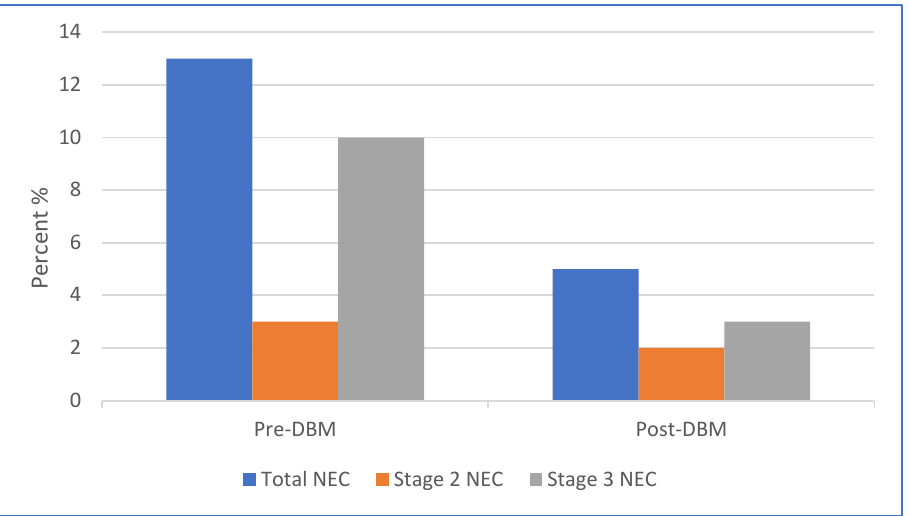
Figure 2. The decrease in NEC and severe NEC between the two infant cohorts.